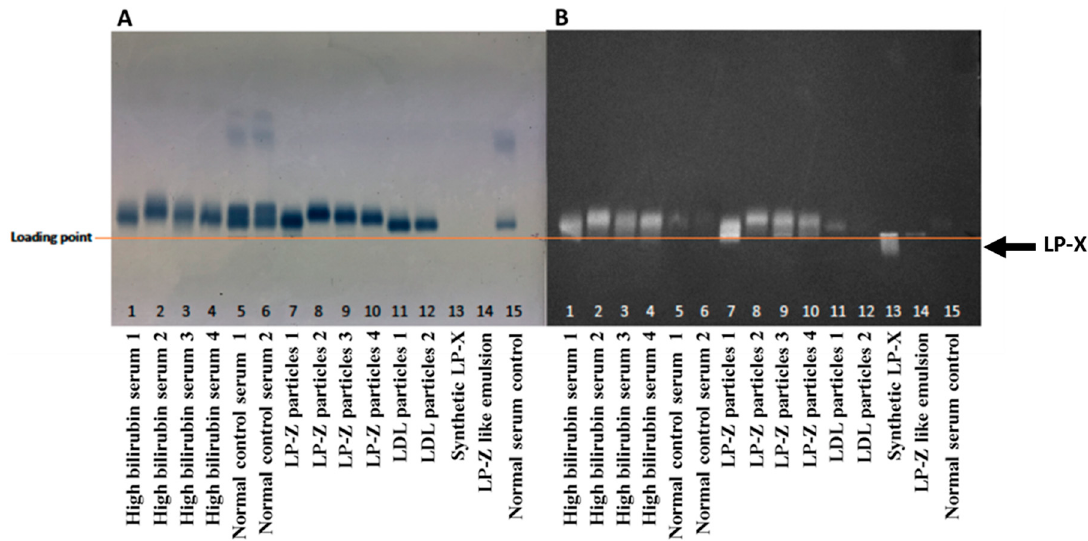
Figure 4. Agarose gel electrophoresis of serum and isolated lipoprotein particle samples to reveal migration of lipoproteins, such as lipoprotein X (LP-X), toward the cathode. ( A ) Sudan Black lipid stained agarose gel and ( B ) Filipin free cholesterol stained agarose